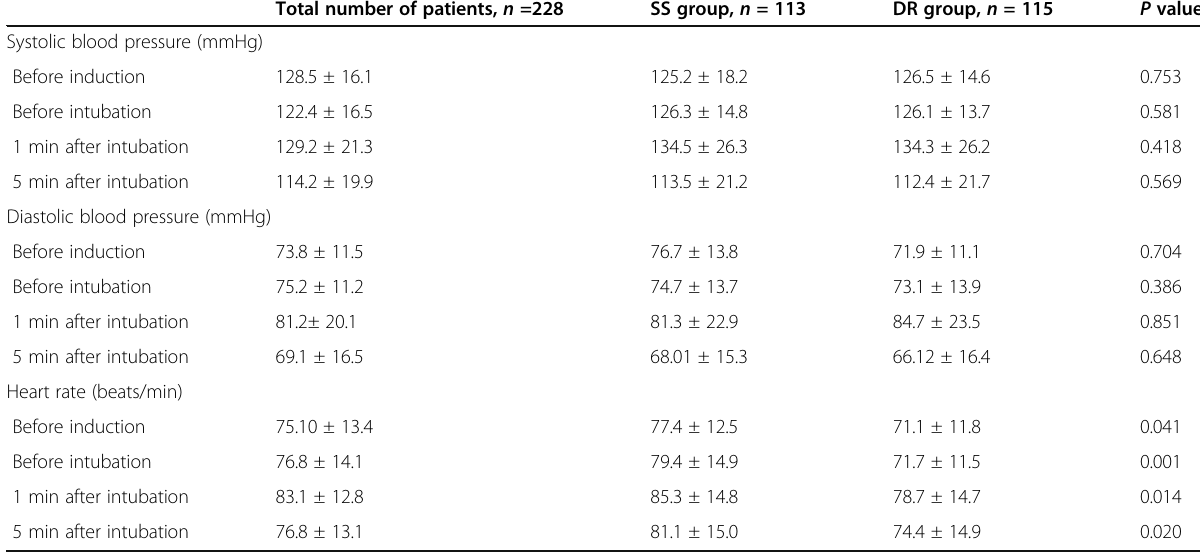
Table 6 Hemodynamic between experimented groups Total number of patients, n